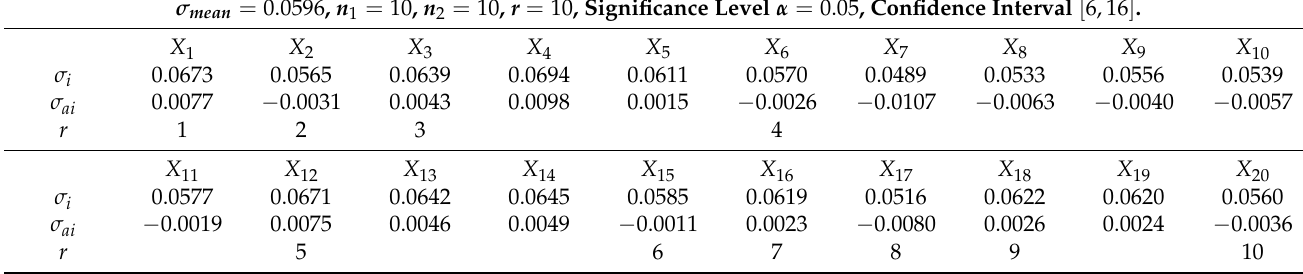
Table 3. Run test process of z -axis raw data.